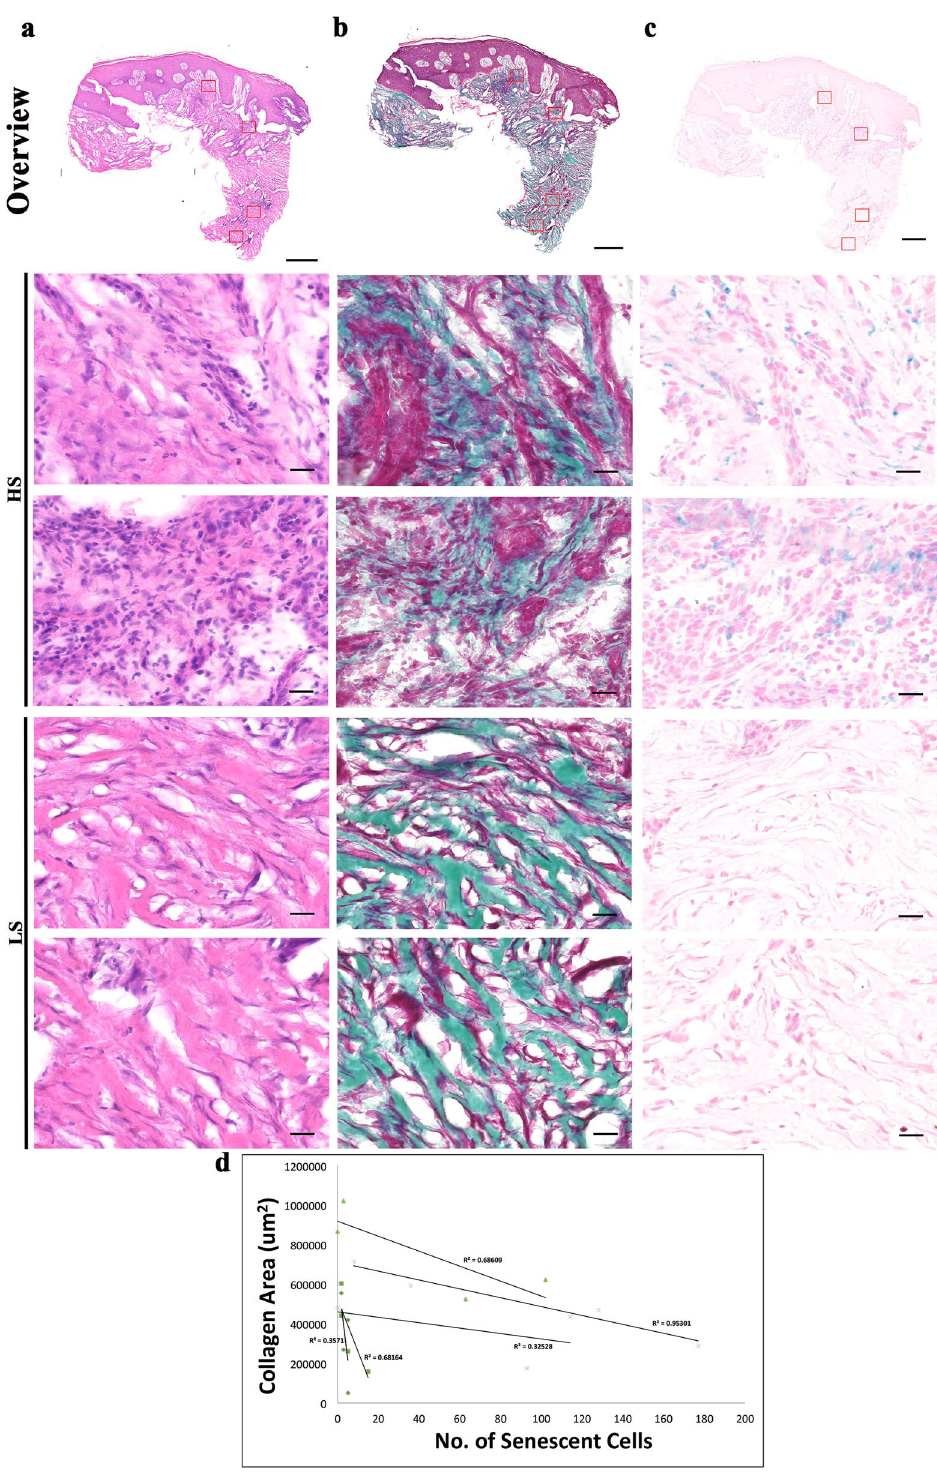
Figure 3. Staining of nuclei, collagen and senescent cells of pressure ulcer biopsies revealed a strong link between presence of senescent cells and collagen area. ( a ) Haematoxylin and eosin staining of nuclei (purple) and extracellular matrix proteins (pink) in a pressure ulcer. Montage of high-power images [1200 (W) × 1000 (H) μm] of an 8 μM thick cryosections—two from high senescence (HS) regions and two from low senescence (LS) regions of a pressure ulcer taken using × 20 objective lens. ( b ) MT staining collagen (green), muscle and keratin (red) and cytoplasm (pink/red) in a sister section. Montage followed by ( c ) X-gal staining as a marker for senescent cells (senescent cells (blue), nuclei and cytoplasm (pink). Scale bars, montage 500 μm and high power 20 μm. ( d ) Regression plots of collagen area (x-axis) against senescent cell number (y-axis) of individual patients of the PRU